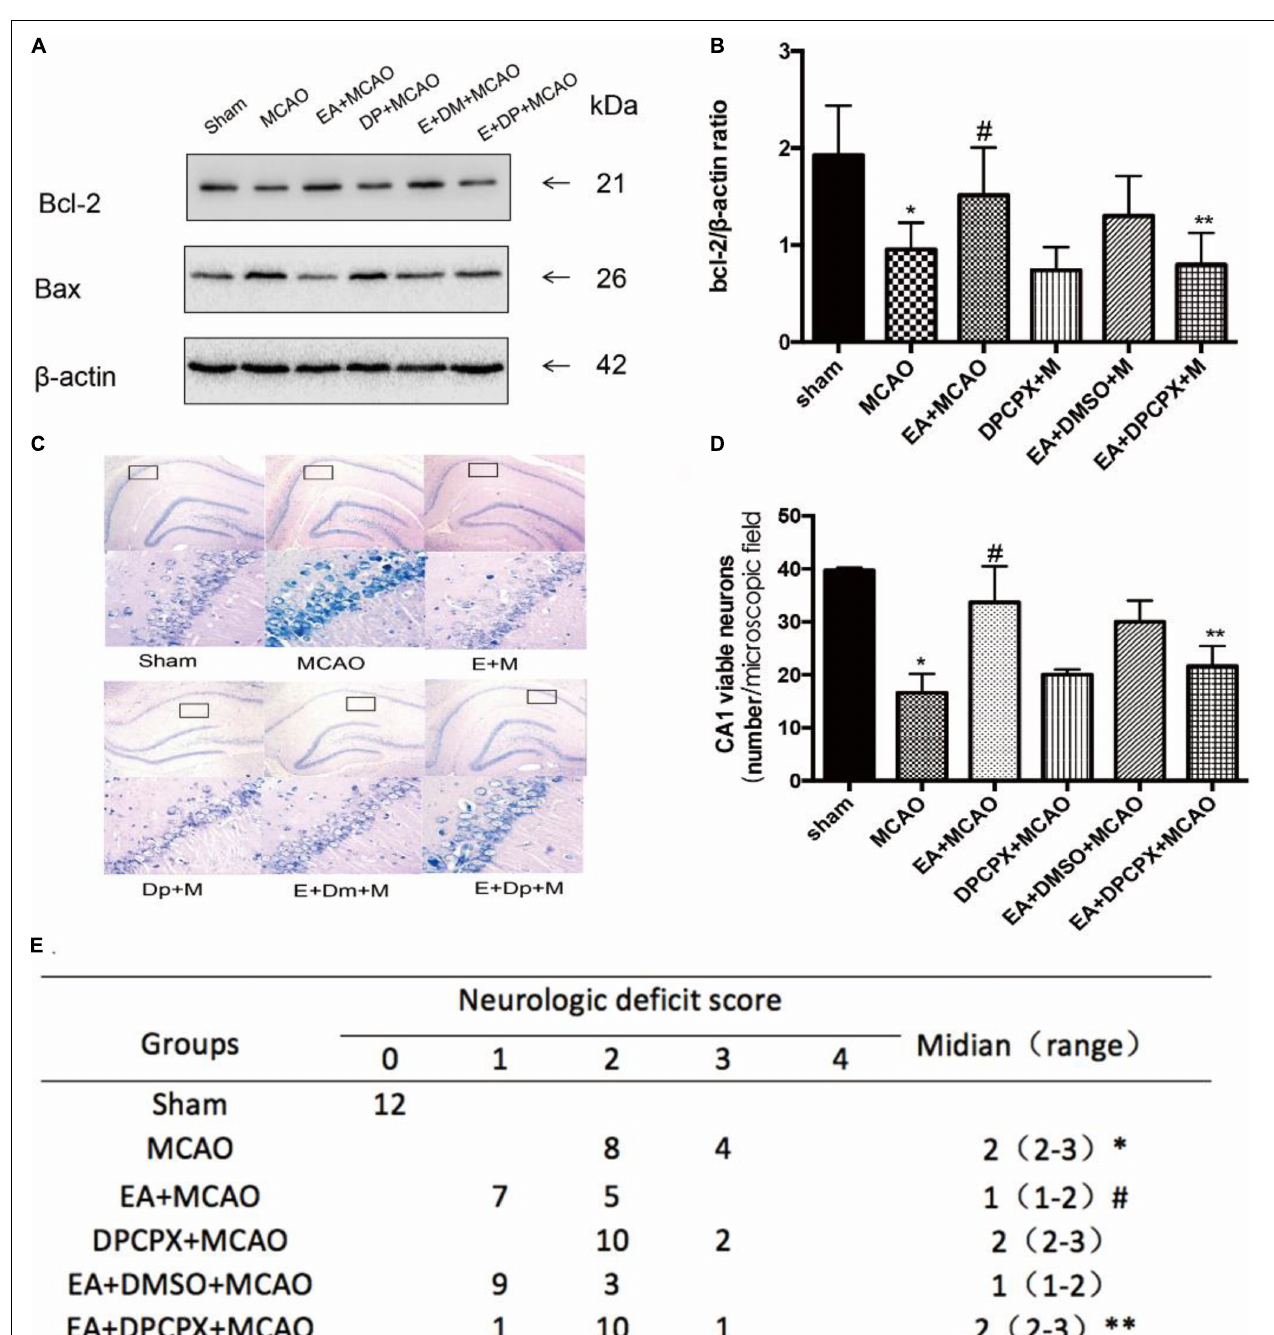
FIGURE 5 | Effect of DPCPX on hippocampus damage induced by electroacupuncture (EA) pretreatment. (A,B) Western blot analysis for Bcl-2 and Bax protein expression in the hippocampus ( n = 3). (C,D) EA pretreatment significantly increases the number of viable pyramidal neurons in the hippocampal CA1 region ( n = 3), whereas DPCPX attenuates these beneficial effects. (E) Neurologic behavior scores were determined 24 h after reperfusion. * P < 0.05 vs. the sham group, # P < 0.05 vs. the MCAO group, ** P < 0.05 vs. the EA + MCAO group.